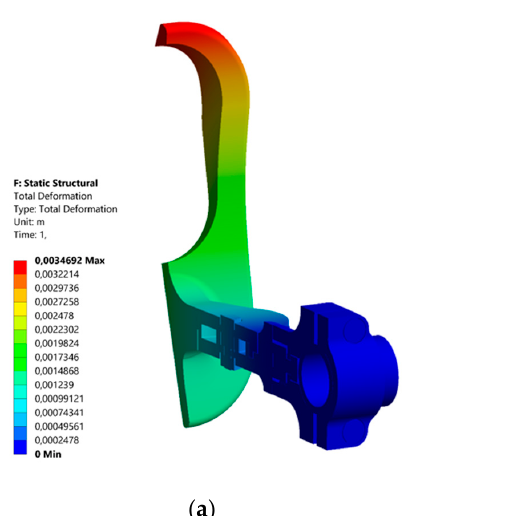
Figure 15. Representation of the results obtained with the finite element model: ( a ) visualization of the distribution of the total displacement; ( b ) visualization of the distribution of the fatigue safety factor for 10 5 cycles.